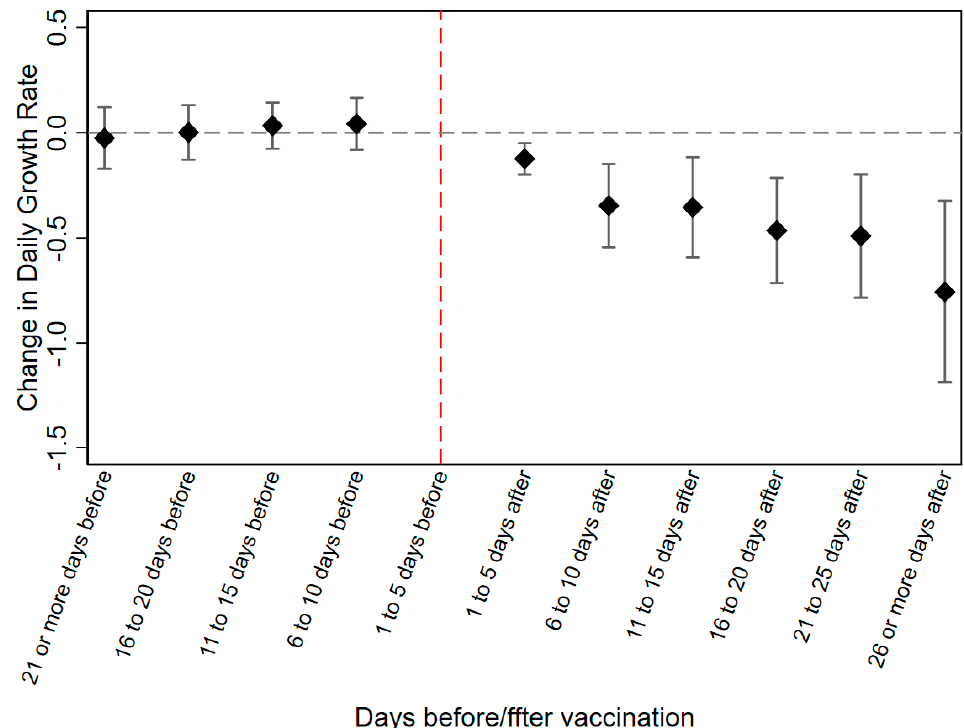
Figure 3. Point estimates and 95% confidence intervals of the effects of vaccination on the daily growth rate of COVID-19 confirmed cases. Table 3. The impact of vaccination on COVID-19 confirmed cases: Results from different models. (1) Main